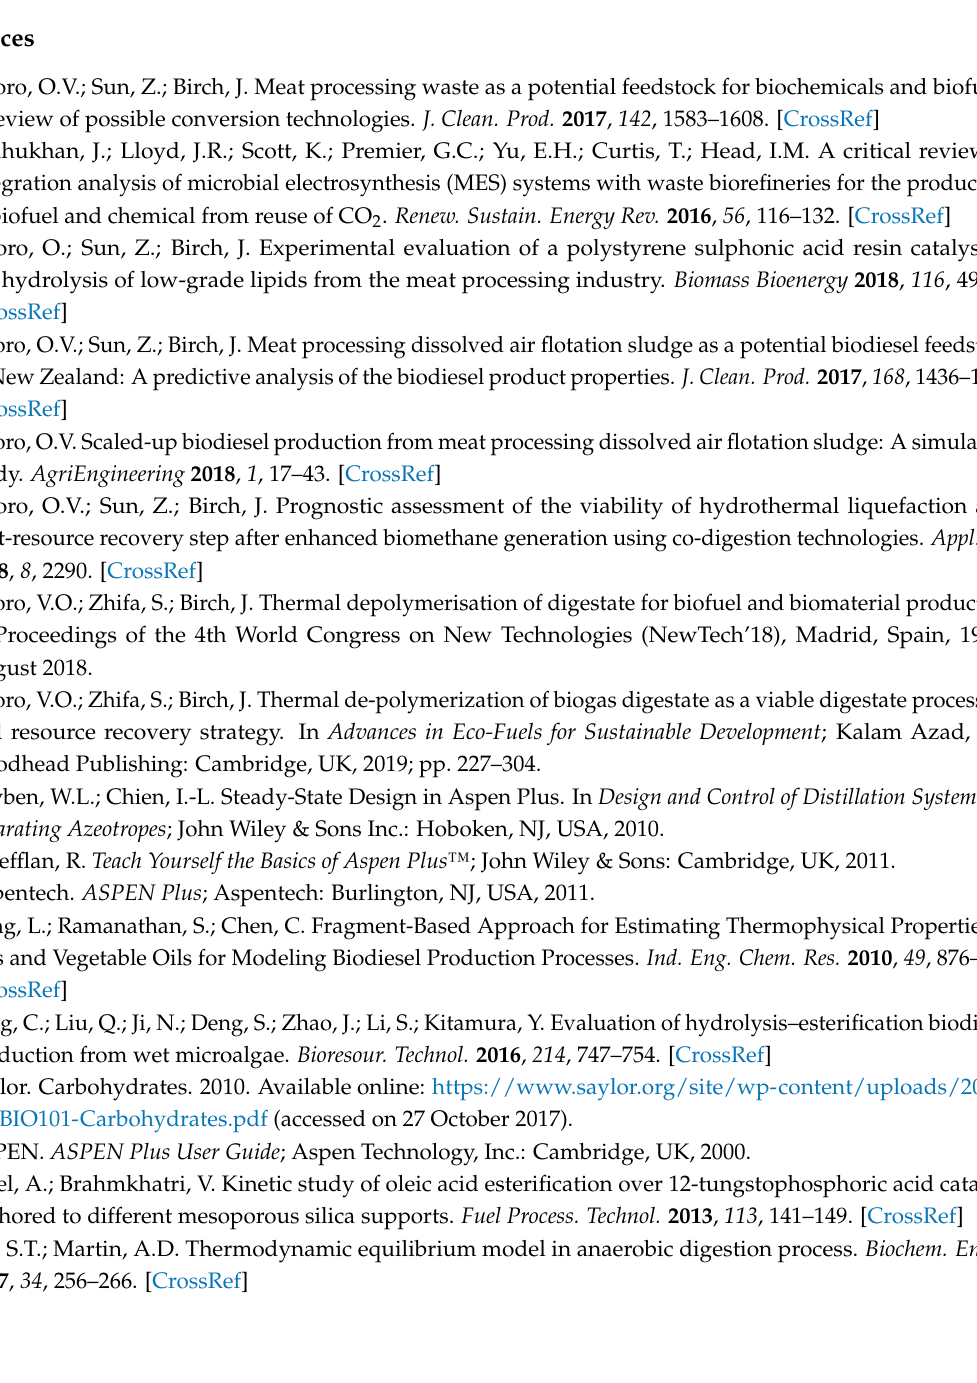
Table S1: The major costing components calculated for different feedstock mass feed rate scenarios, Table S2: Energy input, energy potential and mass flow rate of useful products generated for different feedstock mass feed rate scenarios, Table S3: The major costing components calculated for different TMPS mass feed rates, Table S4: Energy input, energy potential and mass flow rate of useful products generated for different TMPS mass feed rates for case A and Case